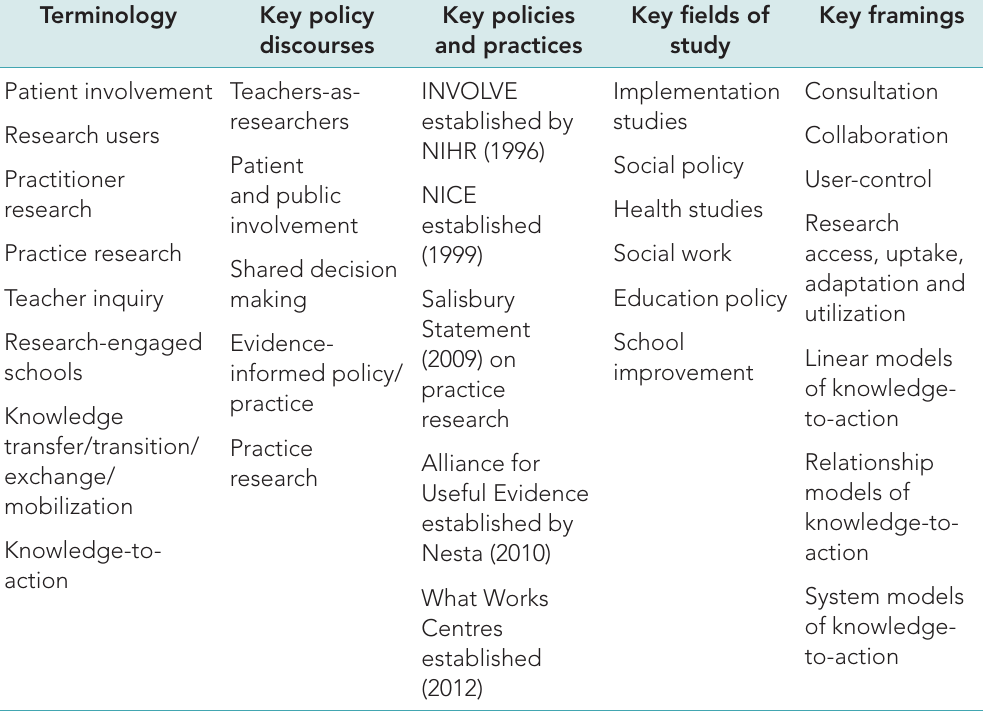
Table 3: Approaches to research engagement within the public policy domain Terminology Key policy Key policies Key fields of Key discourses and practices study